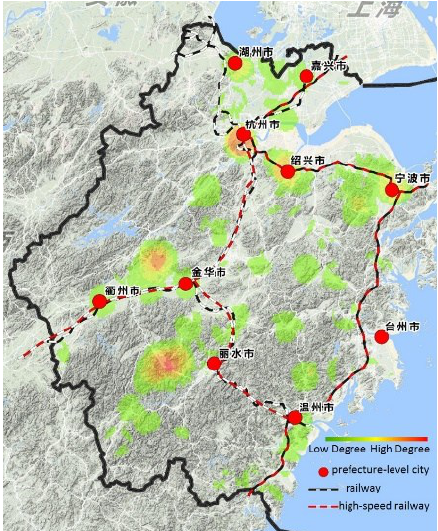
Figure 11. Overlay Map of Cultural Resources Density and